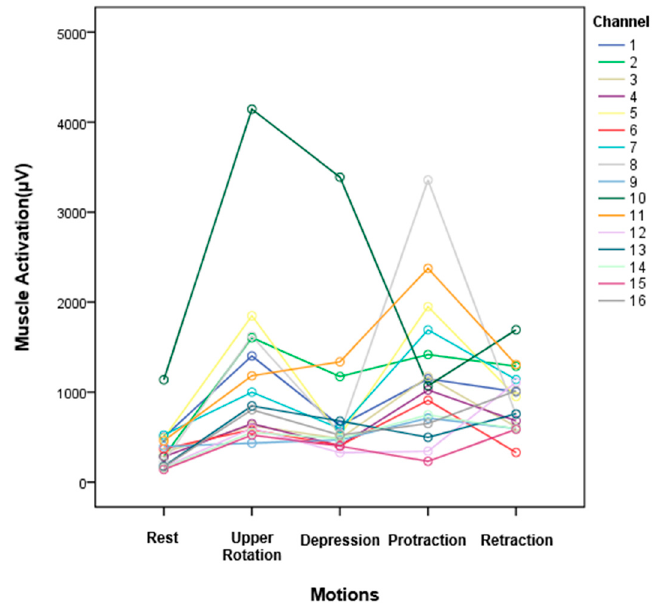
Figure 13. Average root-mean-square (RMS) values of 16-channel sEMG signals of five postures measured from the fabric vest socket.